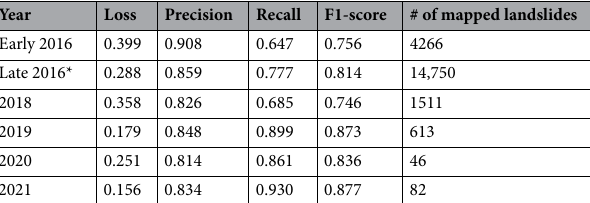
Table 4. Accuracy of mapped landslides in time in Kaikōura, New Zealand. * Co-seismic event